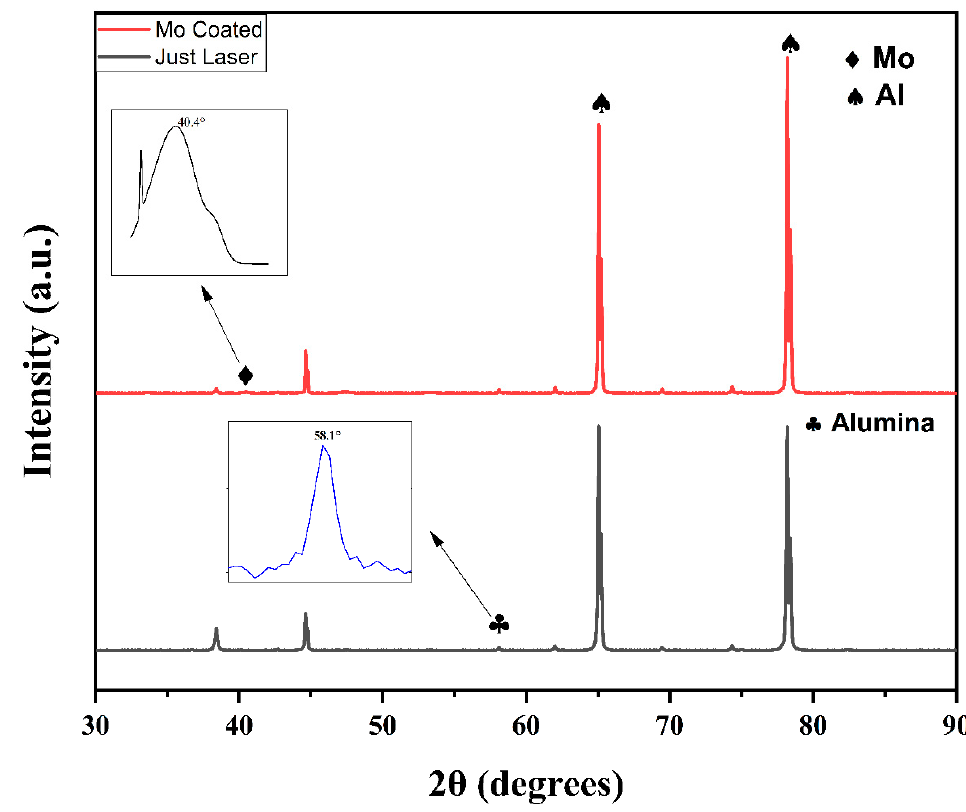
Figure 2. XRD peaks for just laser-structured samples showing major peaks of Al and a small alumina peak at 58.1°; and laser-structured and Mo-coated sample showing the small peak of Mo.